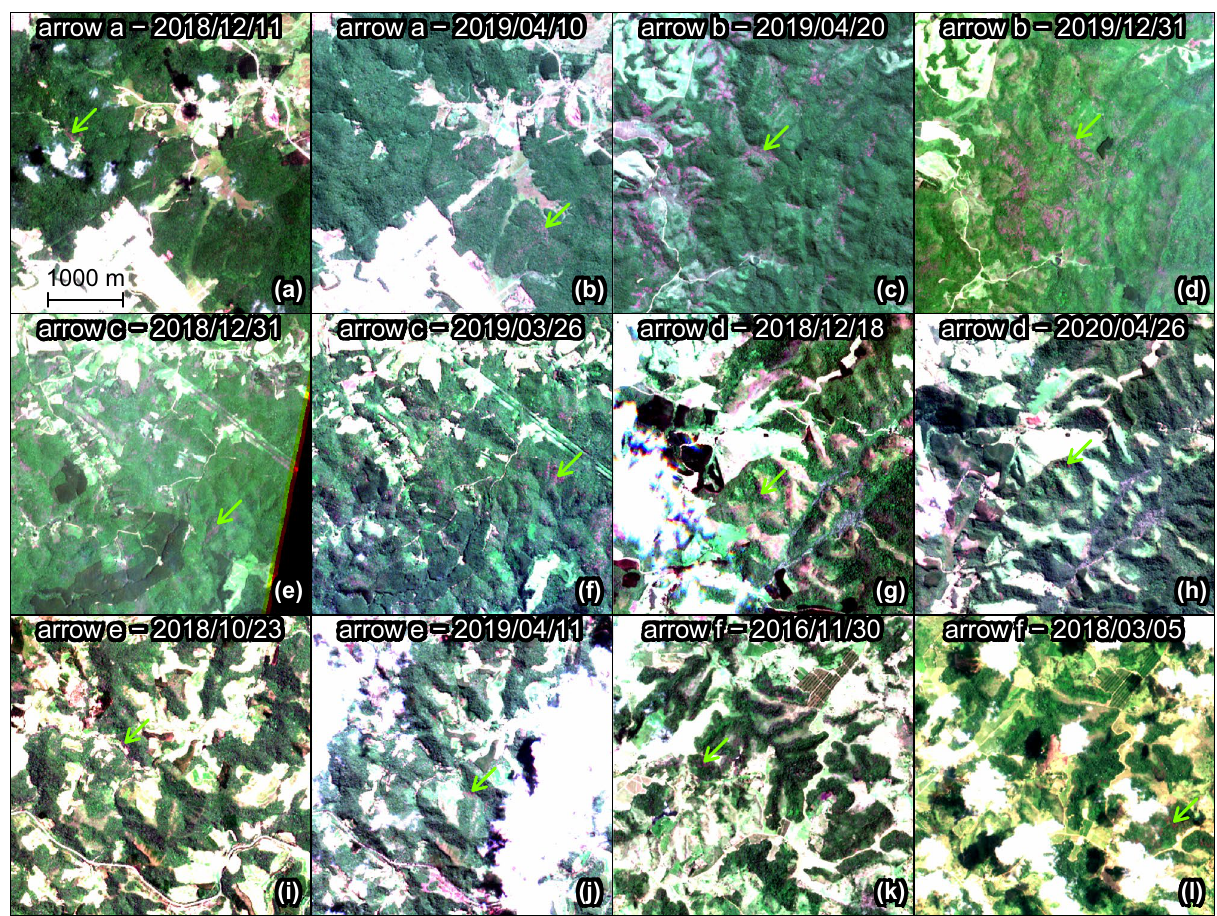
Figure 8. Sentinel-2 image subsets (4 km × 4 km) for the locations with two blossoms per year. Locations of the arrows are given in Fig. 7b. A green arrow shows one of the location of trees with pink flowers in each image. Image equalization with min-max stretching between 0 and 255 for each RGB band was performed to improve contrast and better enable visual detection of the pink flowering trees.